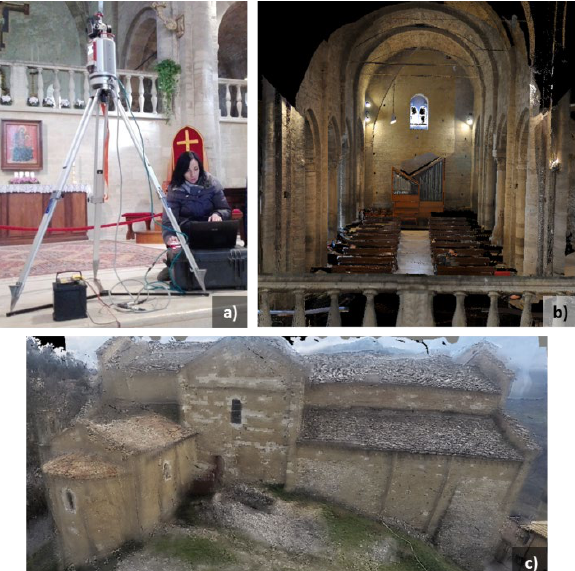
Figure 11. a) Surveying activities for the 3D documentation